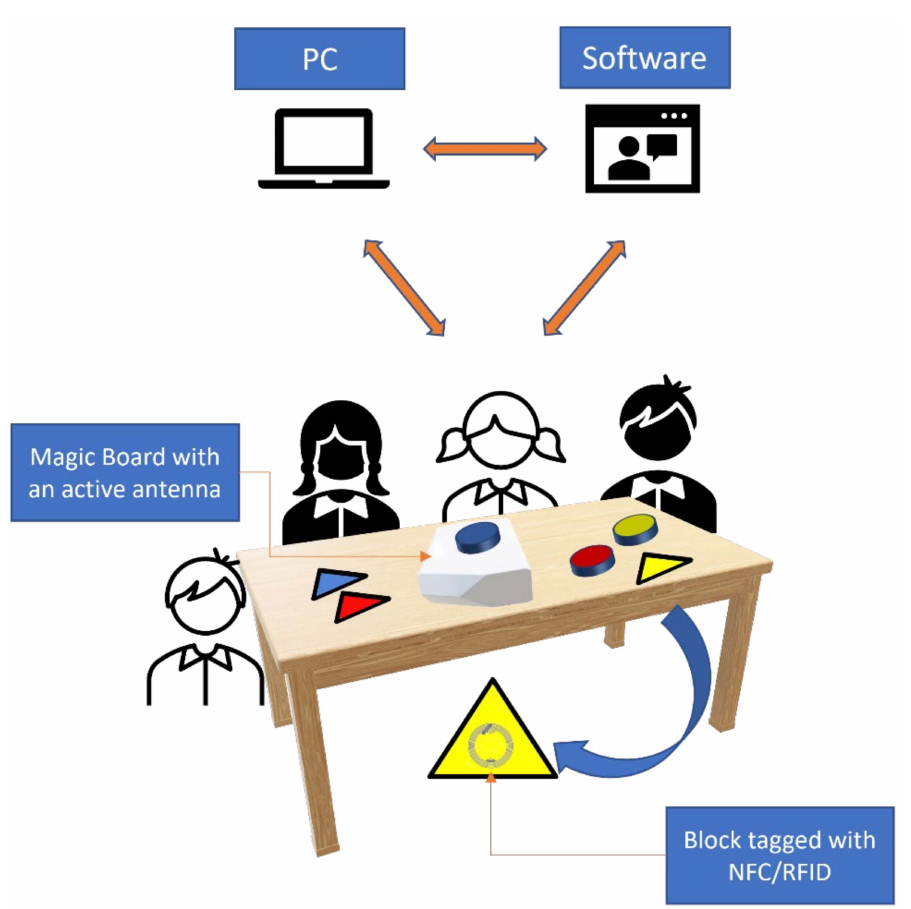
Figure 2. Block Magic